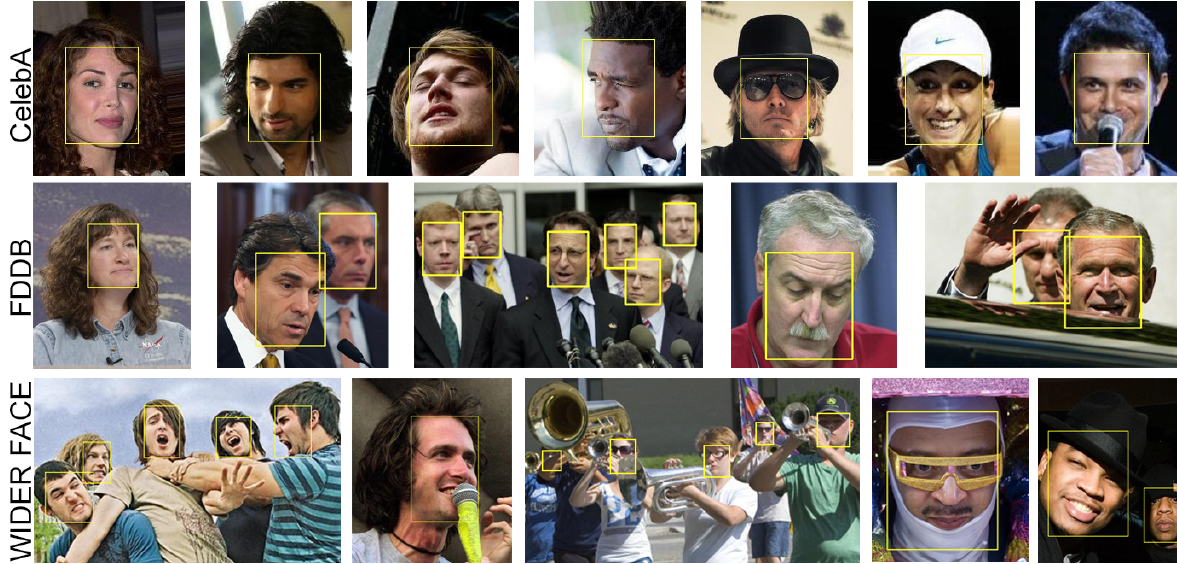
Figure 7. Example of a dataset used for face